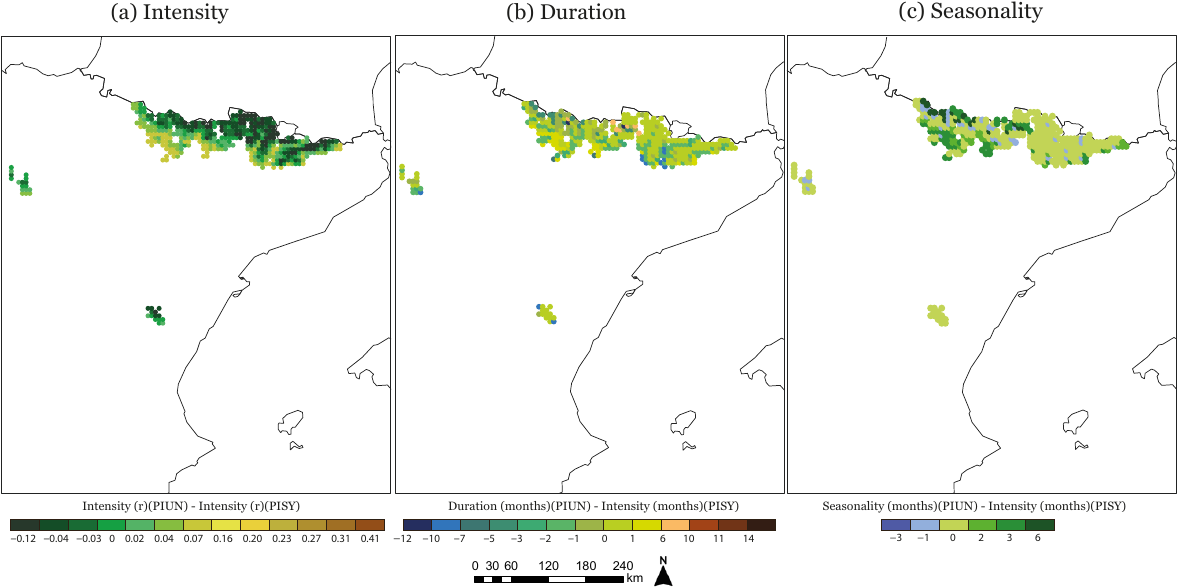
Figure 6. Differences in intensity ( a ), duration (in months) ( b ), and seasonality (in months) ( c ) between P. uncinata and P. sylvestris across coexistence distribution area. Positive values (or months) indicate that P. uncinata shows higher values (or months) than P. sylvestris